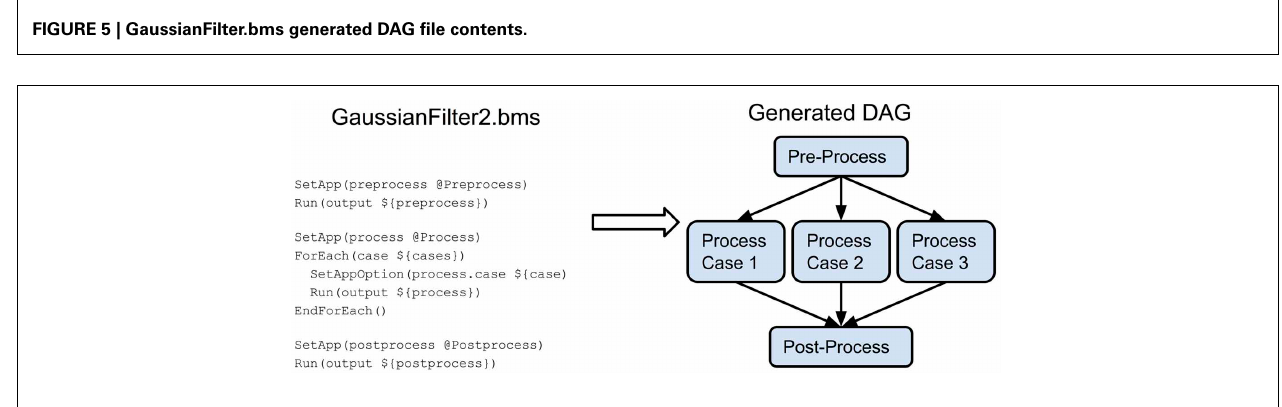
FIGURE 6 | GaussianFilter2.bms and generated DAG.